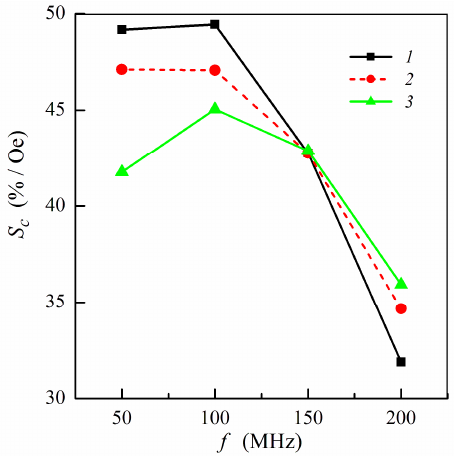
Figure 6. Frequency dependence of the concentration sensitivity S c : curve 1, symmetric multilayered film ( m = n = 4); curve 2, non-symmetric multilayer with ferrogel placed onto the surface of thin layer ( m = 3, n = 4); curve 3, non-symmetric multilayer with ferrogel placed onto the surface of thick layer ( m = 4, n = 3). Other parameters used for calculations are the same as in Figure